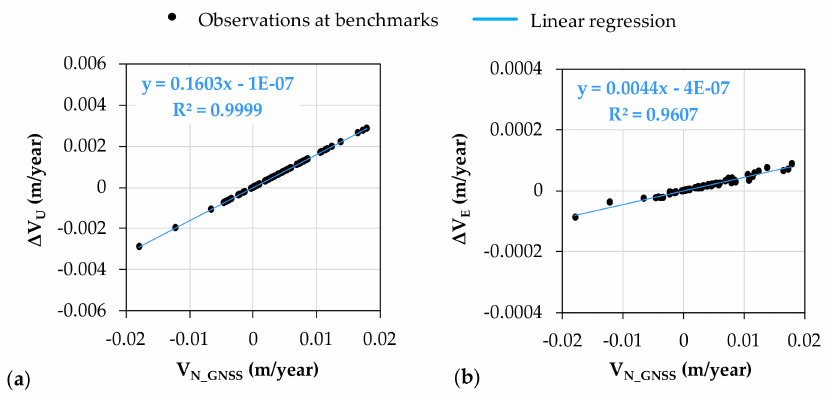
Figure 15. Estimated magnitude of the contribution to the observed velocity differences ( a ) ∆ V U and ( b ) ∆ V E that is made by the V N = 0